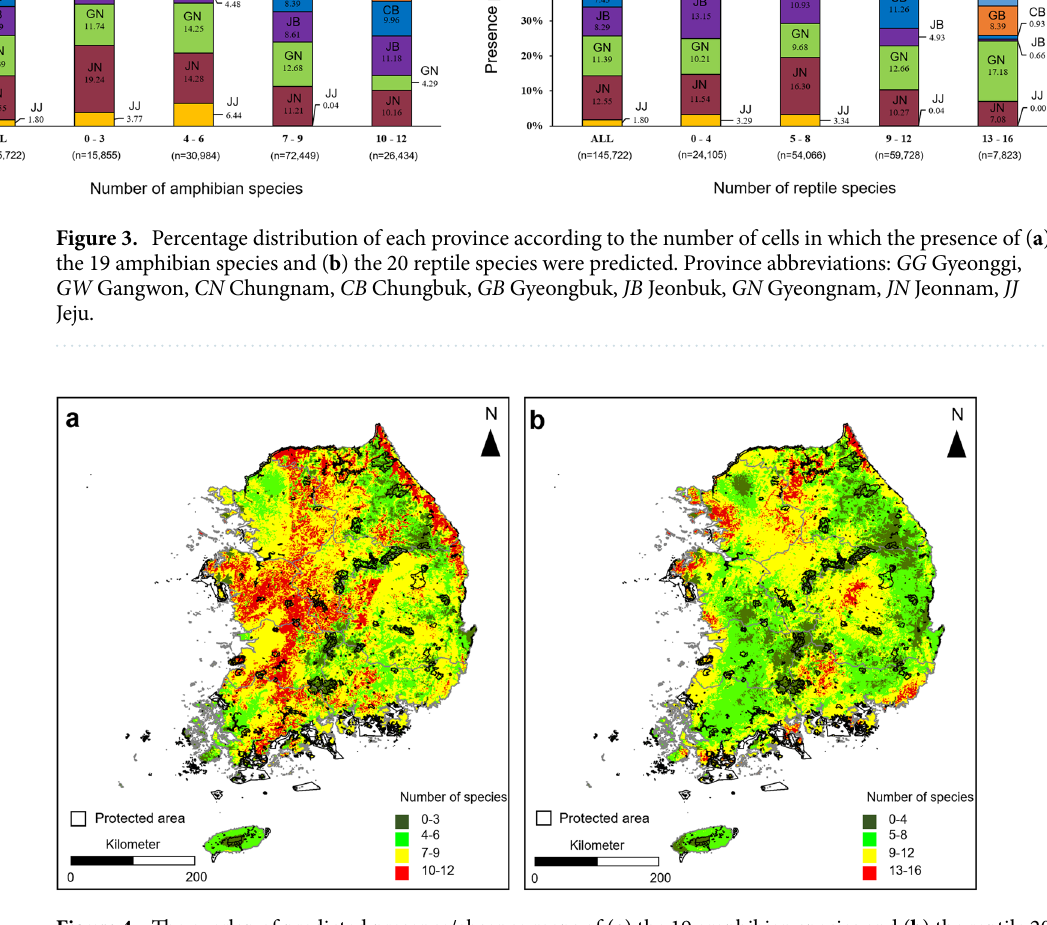
Figure 4. The overlap of predicted presence/absence maps of ( a ) the 19 amphibian species and ( b ) the reptile 20 species in South Korea. This map was generated using the tool of ArcGIS 10.3 (ESRI, Redlands, CA, USA, http:// www. esri.